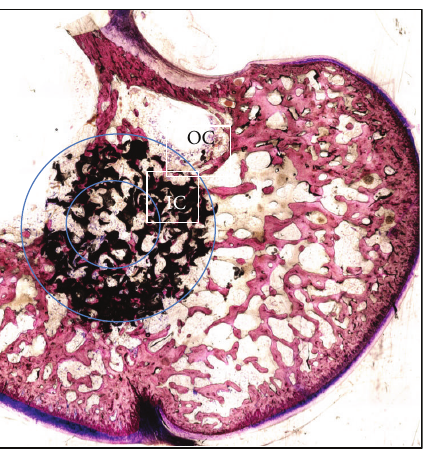
Figure 1: Schematic representation of a condyle section. The newly formed bone and the residual material distribution were evaluated separately in the inner (IC) and outer zones (OC) at 6 weeks after